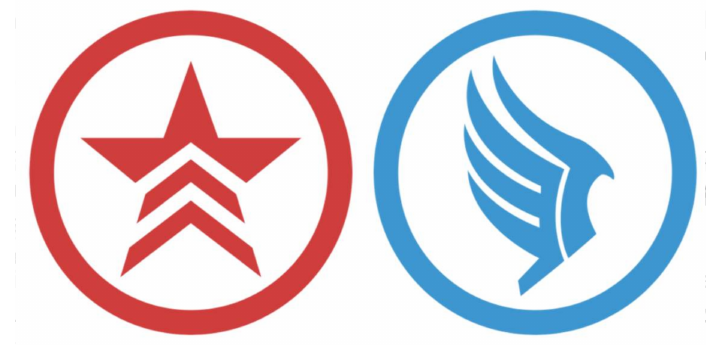
Figure 3. “Interrupt” symbols 17